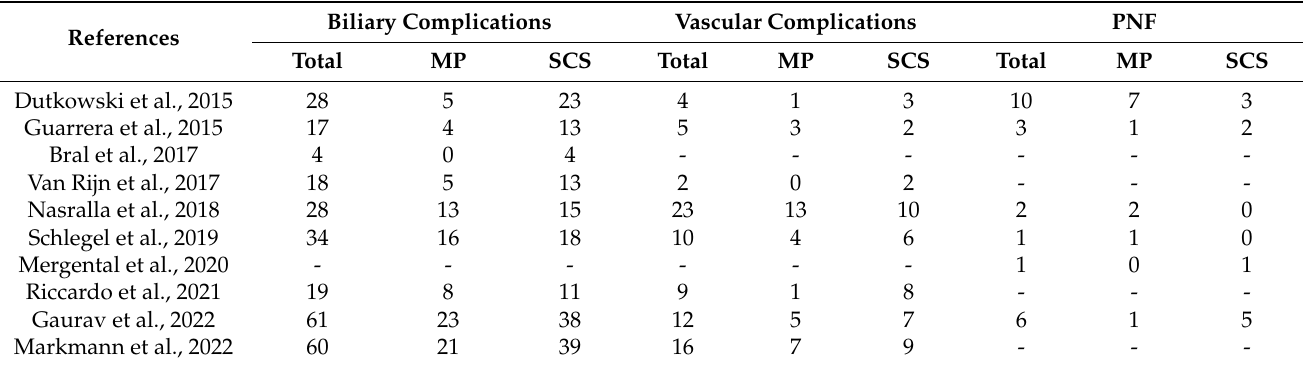
Table 3. Postoperative complications.